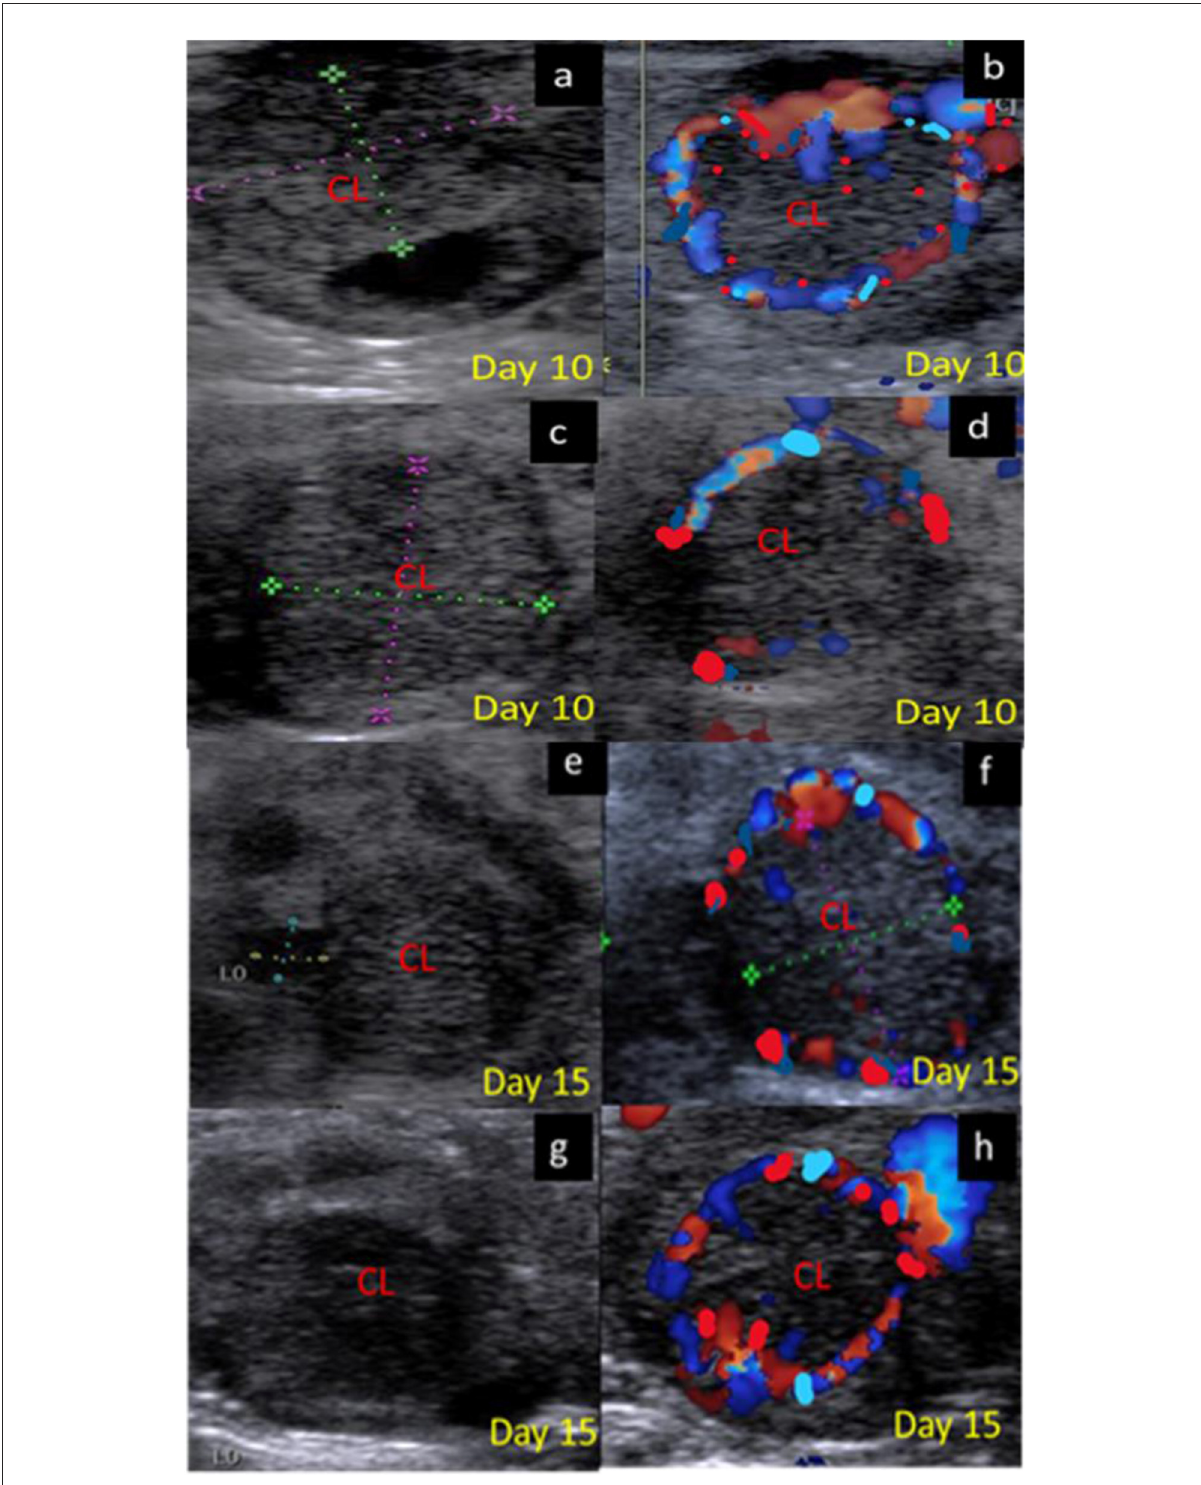
FIGURE5 B-mode and colored ultrasonograms of a 9-year-old buffalos at the mid luteal phase with two stages stage II; from 6 to 10 days and stage; III from 11 to 16 days, as (a,b) images showed the corpus luteum in non-pregnant female on day 10 in gray and color modes, (c,d) images showed the formed corpus luteum in suspected pregnant one on day 10 in gray and color modes, (e,f) images showed the corpus luteum in non-pregnant female on day 15 in gray and color modes, and (g,h) images showed the formed corpus luteum in suspected pregnant one on day 15 in gray and color modes. CL, corpus